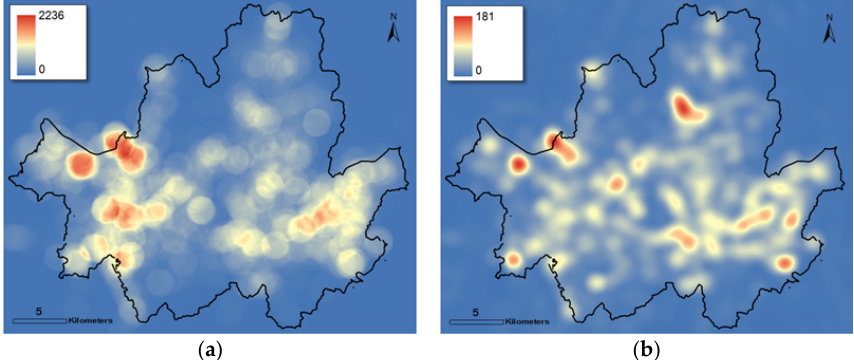
Figure 3. Geostatistical density of geotechnical information based on ( a ) point density and ( b ) kernel density.